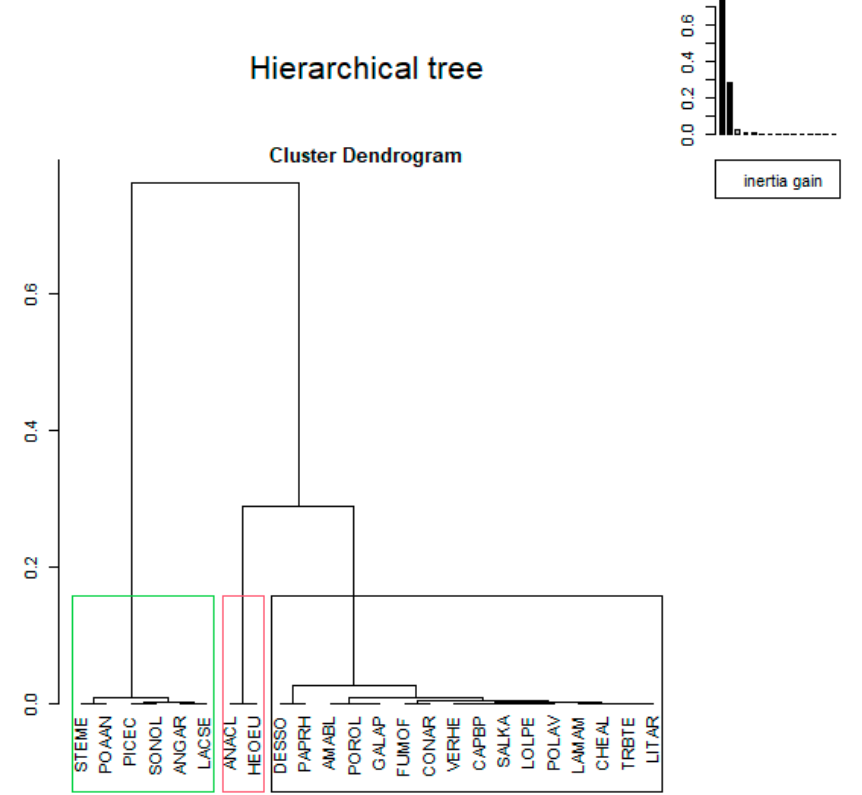
Figure 4. Plots graphs from a HCPC result: hierarchical tree. The dendrogram suggests a three clus- ters solution. In this tree visualize individuals (weed species) on the principal component map and to color individuals according to the cluster they belong to: Black: M site-extraction-2018, 2019, 2020; Red: M site-germination-2020 and Green: S site-extraction and germination-2018, 2019, 2020.